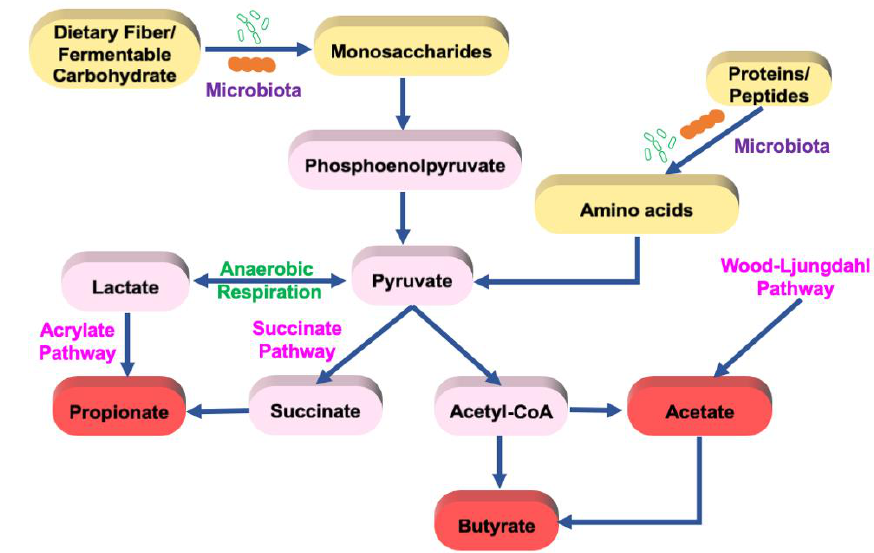
Figure 2. Pathways of SCFAs production by the gut microbiota. Gut bacteria produce SCFAs mainly by the following pathways: acetate is produced from acetyl-CoA (derived from the glycolytic pathway) or and Wood–Ljungdahl pathway, butyrate is produced from acetate and acetyl-CoA, and propionate is produced from the succinate and lactate through their respective pathways.